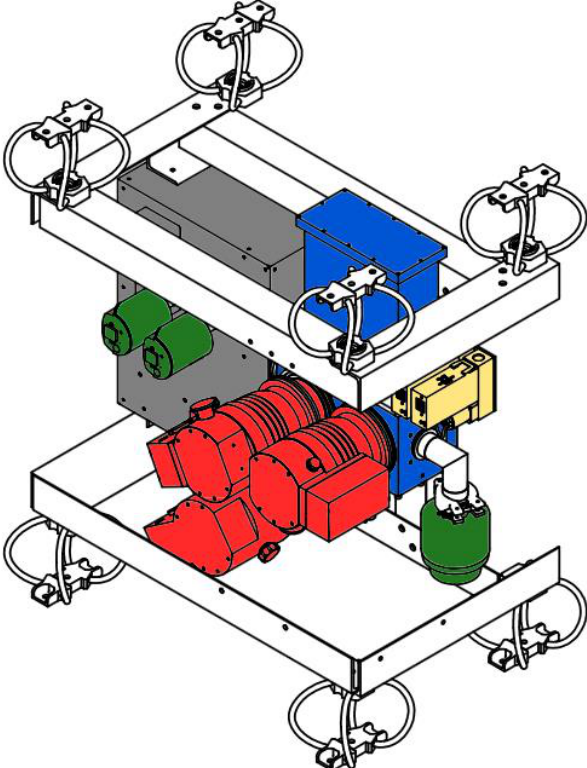
Figure 2. 3-D sketch of the compact PTR-ToF-MS as mounted in the P-3B flight rack. The color-coded components are as follows: Figure 2. 3D-sketch of the compact PTR-ToF-MS as mounted in the P-3B flight rack. The 3 thermostatted enclosure housing the glow discharge–ion drift tube color-coded components are as follows: thermostatted enclosure housing the glow discharge – 4 (grey); ion transfer optics and ToF-MS flight tube (blue); turbo- molecular pumps (red); pressure gauges (green) and electronic mass ion drift tube (grey), ion transfer optics and ToF-MS flight tube (blue), turbomolecular pumps 5 flow and pressure controllers (red), pressure gauges (green) and electronic mass flow and pressure controllers (yellow). 6